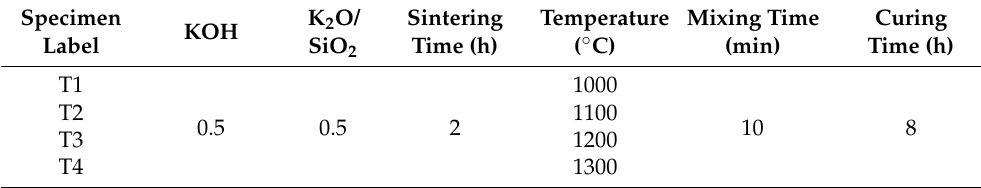
Table 4. Mixing proportion at different calcining